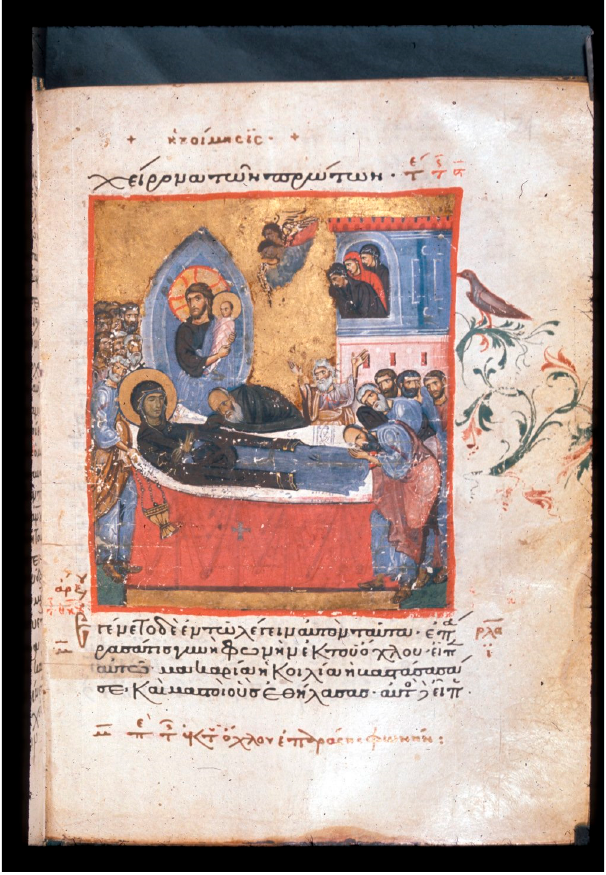
Figure 3. Dormition of the Theotokos , miniature, late 12th century, Harley MS 1810 , fol. 174r, 22.5 × 16.5 cm (page), The British Library , London. (Photo credit: The British Library ).